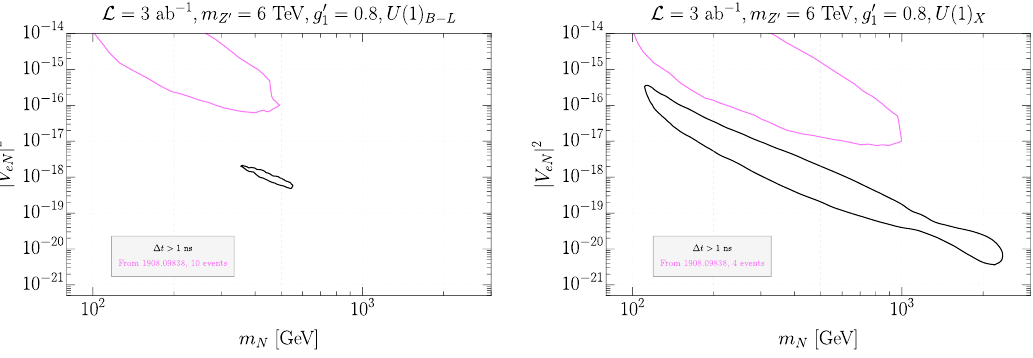
Figure 11 . The 95% C.L. sensitivity reaches in the | V eN | 2 vs. m N plane for both U(1) B − L and U(1) X models. The pink curves are extracted from ref.